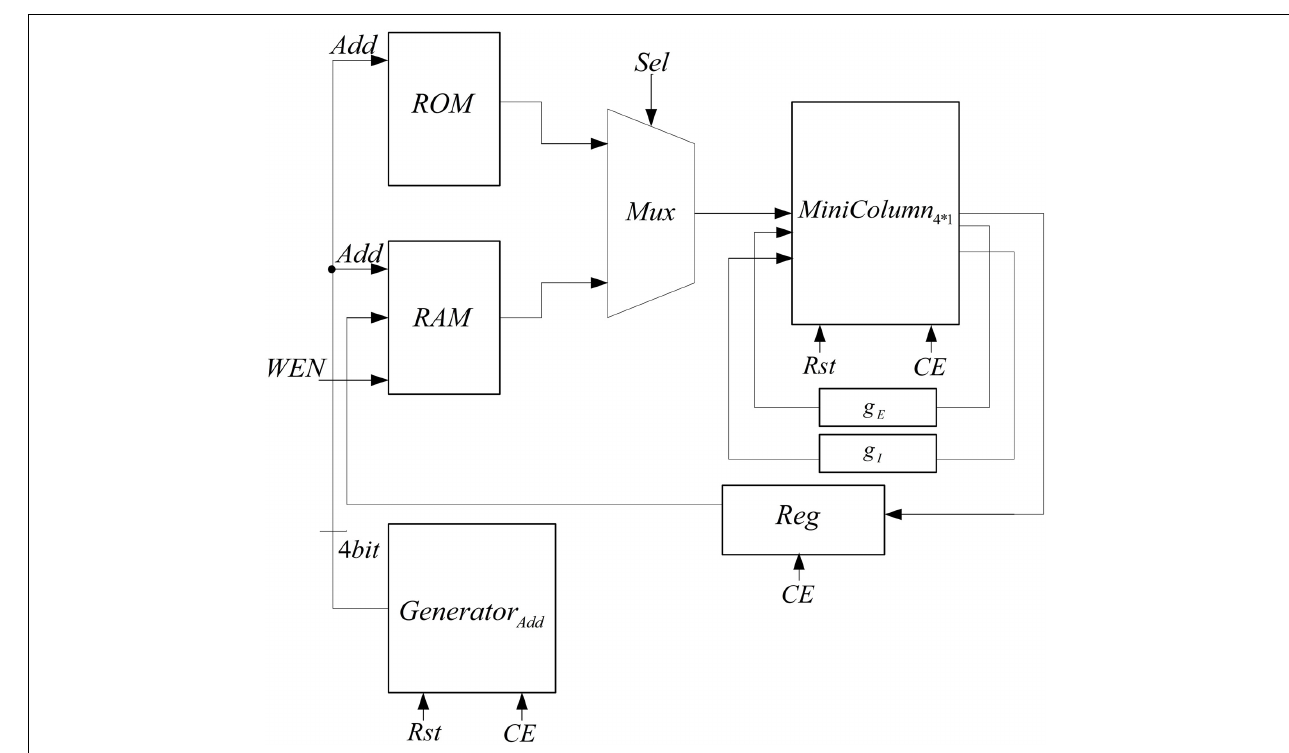
FIGURE 7 | The proposed architecture to increase the number of neurons in the